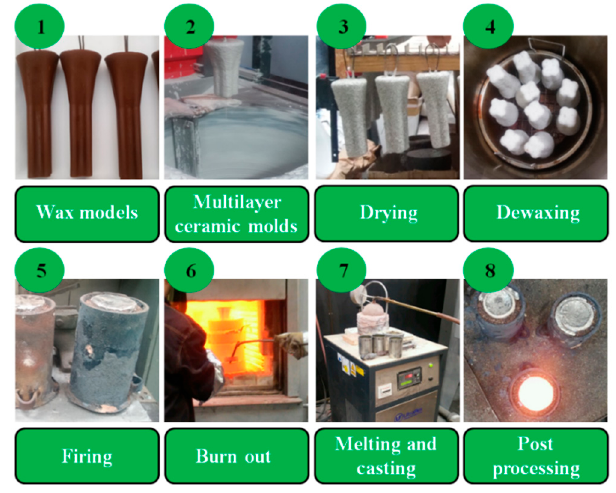
Figure 2. All stages of shell molds and castings preparation.